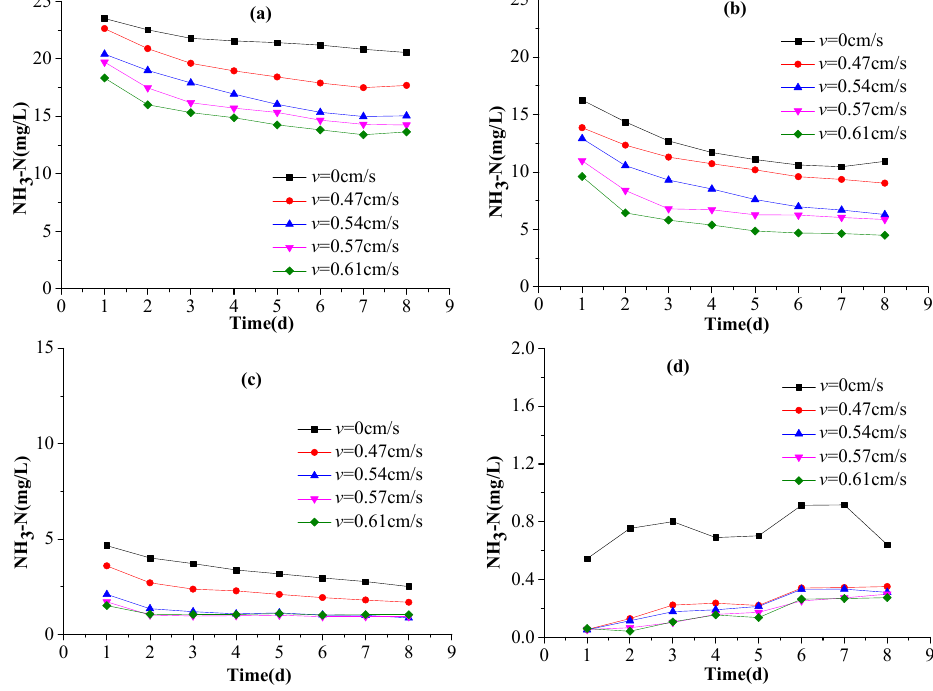
Figure 6. The concentrations of ammonia nitrogen (NH 3 -N) in the sediment at depths of: ( a ) 6 cm; ( b ) 3 cm; ( c ) 1 cm; and ( d ) in the overlying water, throughout the experiment.